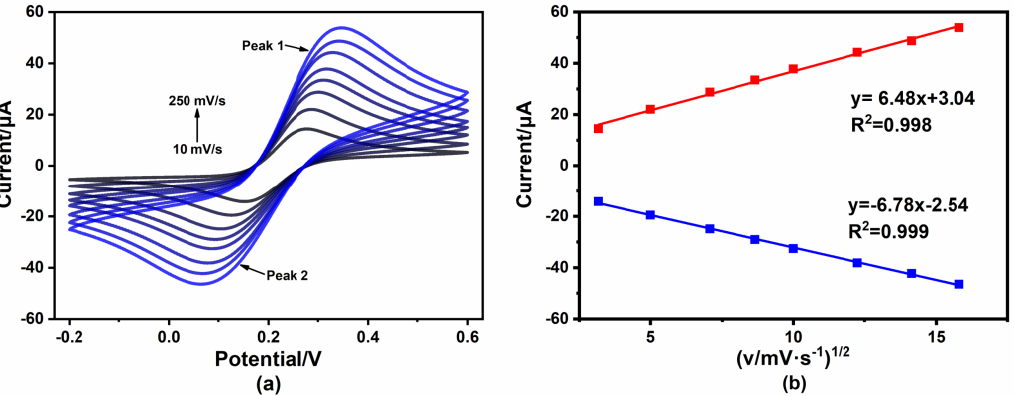
Figure 3. ( a ) CV curves of 4-MPY/Au in 10 µ g/L Hg 2+ (in 0.1 M KCl with 5 mM [Fe(CN) 6 ] 3 − /4 − ) at different scan rates (10–250 mV · s − 1 ); ( b ) the relationship between the REDOX peak current and the square root of scan rate.